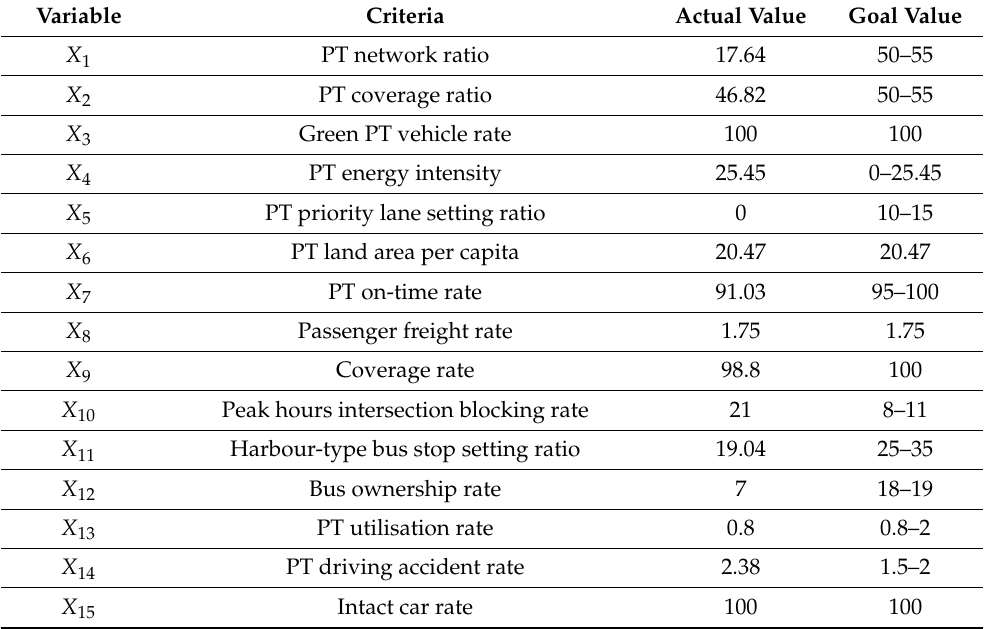
Table 1. Bayswater’s actual and goal values for decision variables.